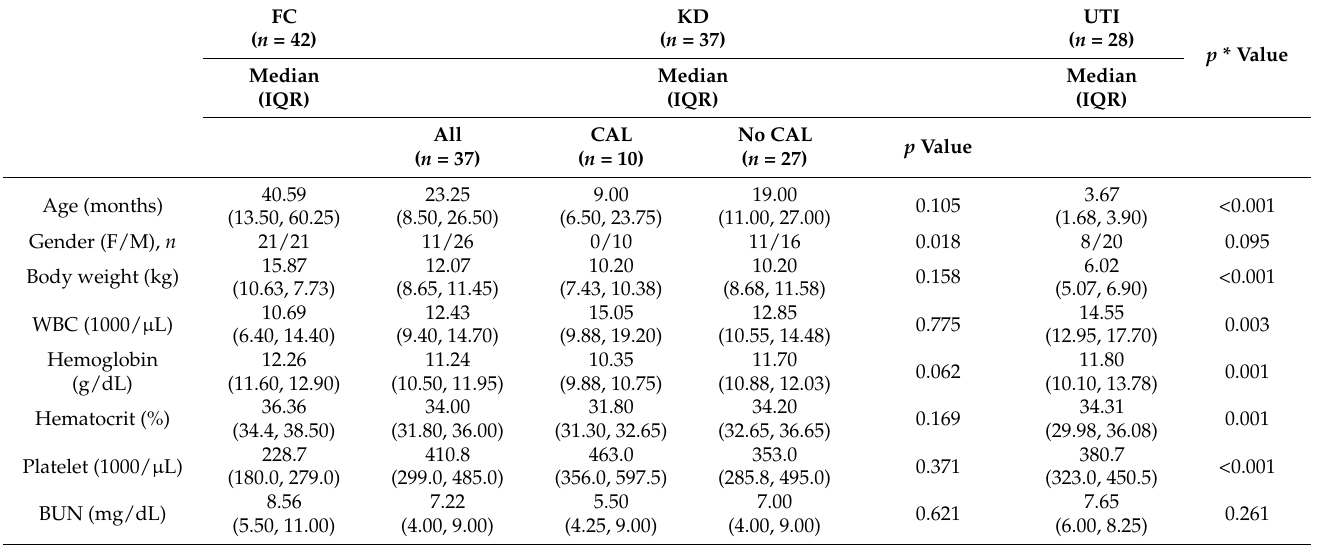
Table 1. Demographic and clinical data of included